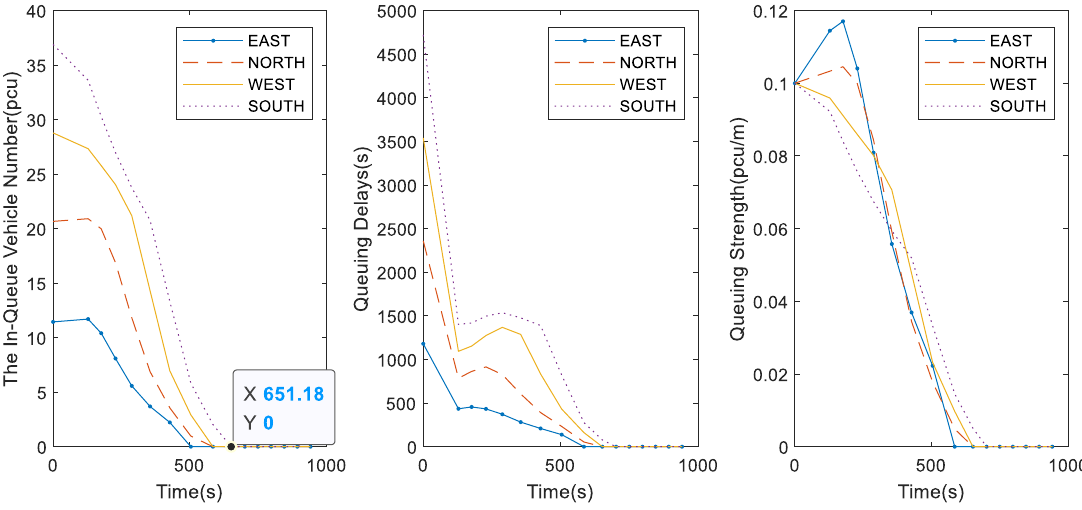
Figure 1. The queuing index of MA-DD-DACC algorithm.